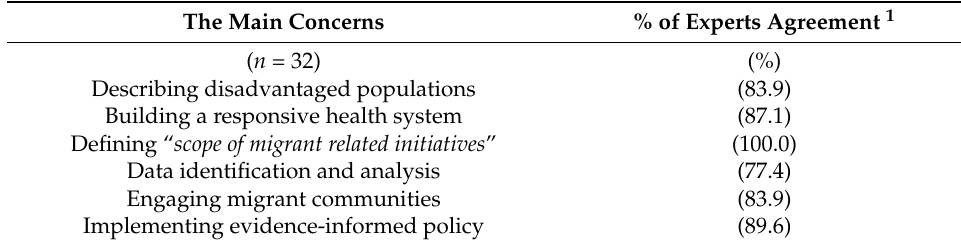
Table A4. Percentage of Experts’ Agreement on Policy